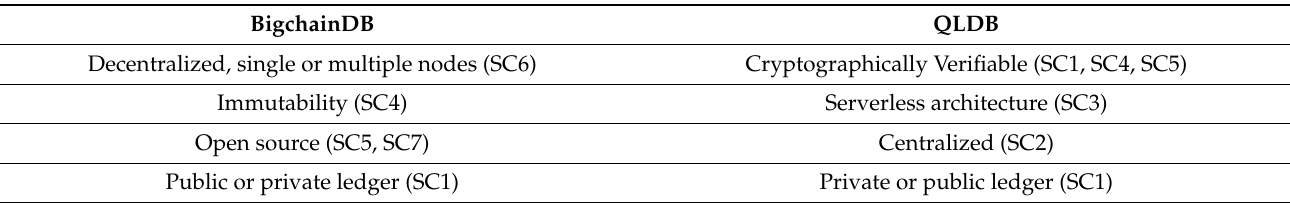
Table 7. BigchainDB and QLDB features against the specific